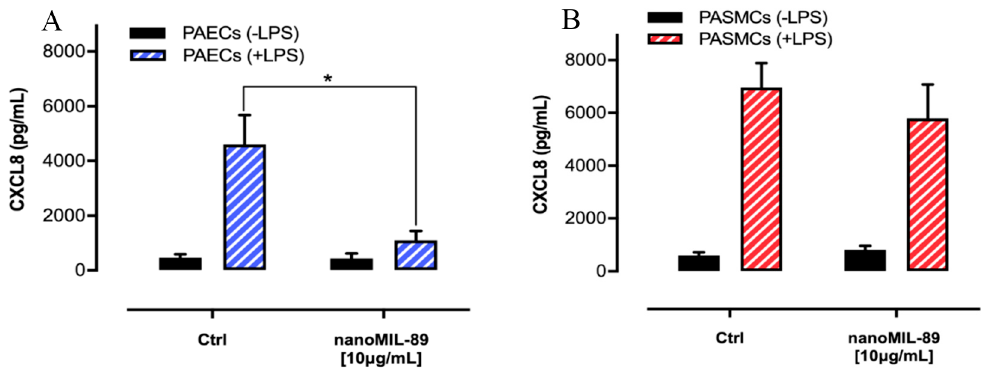
Figure 3. Effect of nanoMIL-89 on the release of C-X-C Motif Chemokine Ligand 8 (CXCL8) from ( A ) PAECs and ( B ) PASMCs. Cells were cultured in ( − LPS/+LPS) media and treated with nanoMIL-89 (10 µg/mL). Data are mean ± SEM; n = 3. Statistical analysis was carried out by two-way ANOVA followed by Bonferroni Posttests ( P * < 0.05).